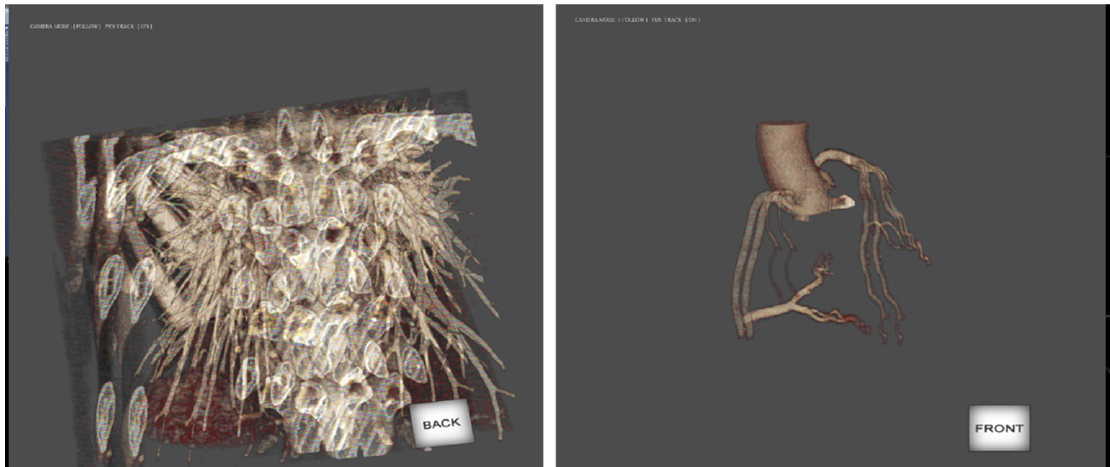
Figure 13. Unclear left- and right-view separation resulting from failed eye tracking. The resulting